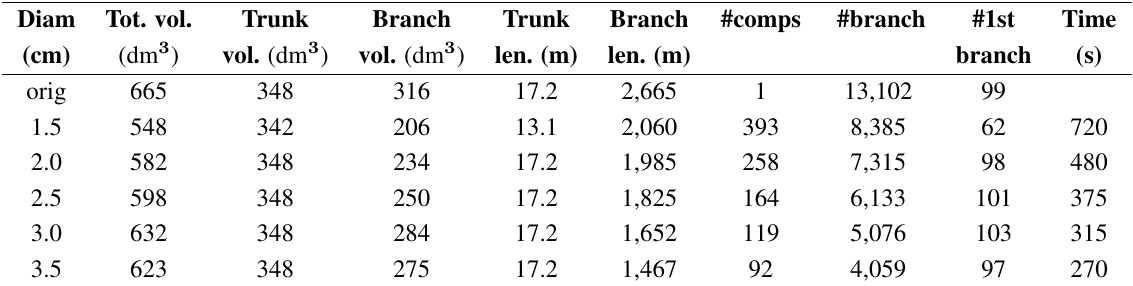
Table 2. Effects of the cover set diameter, with columns as above.